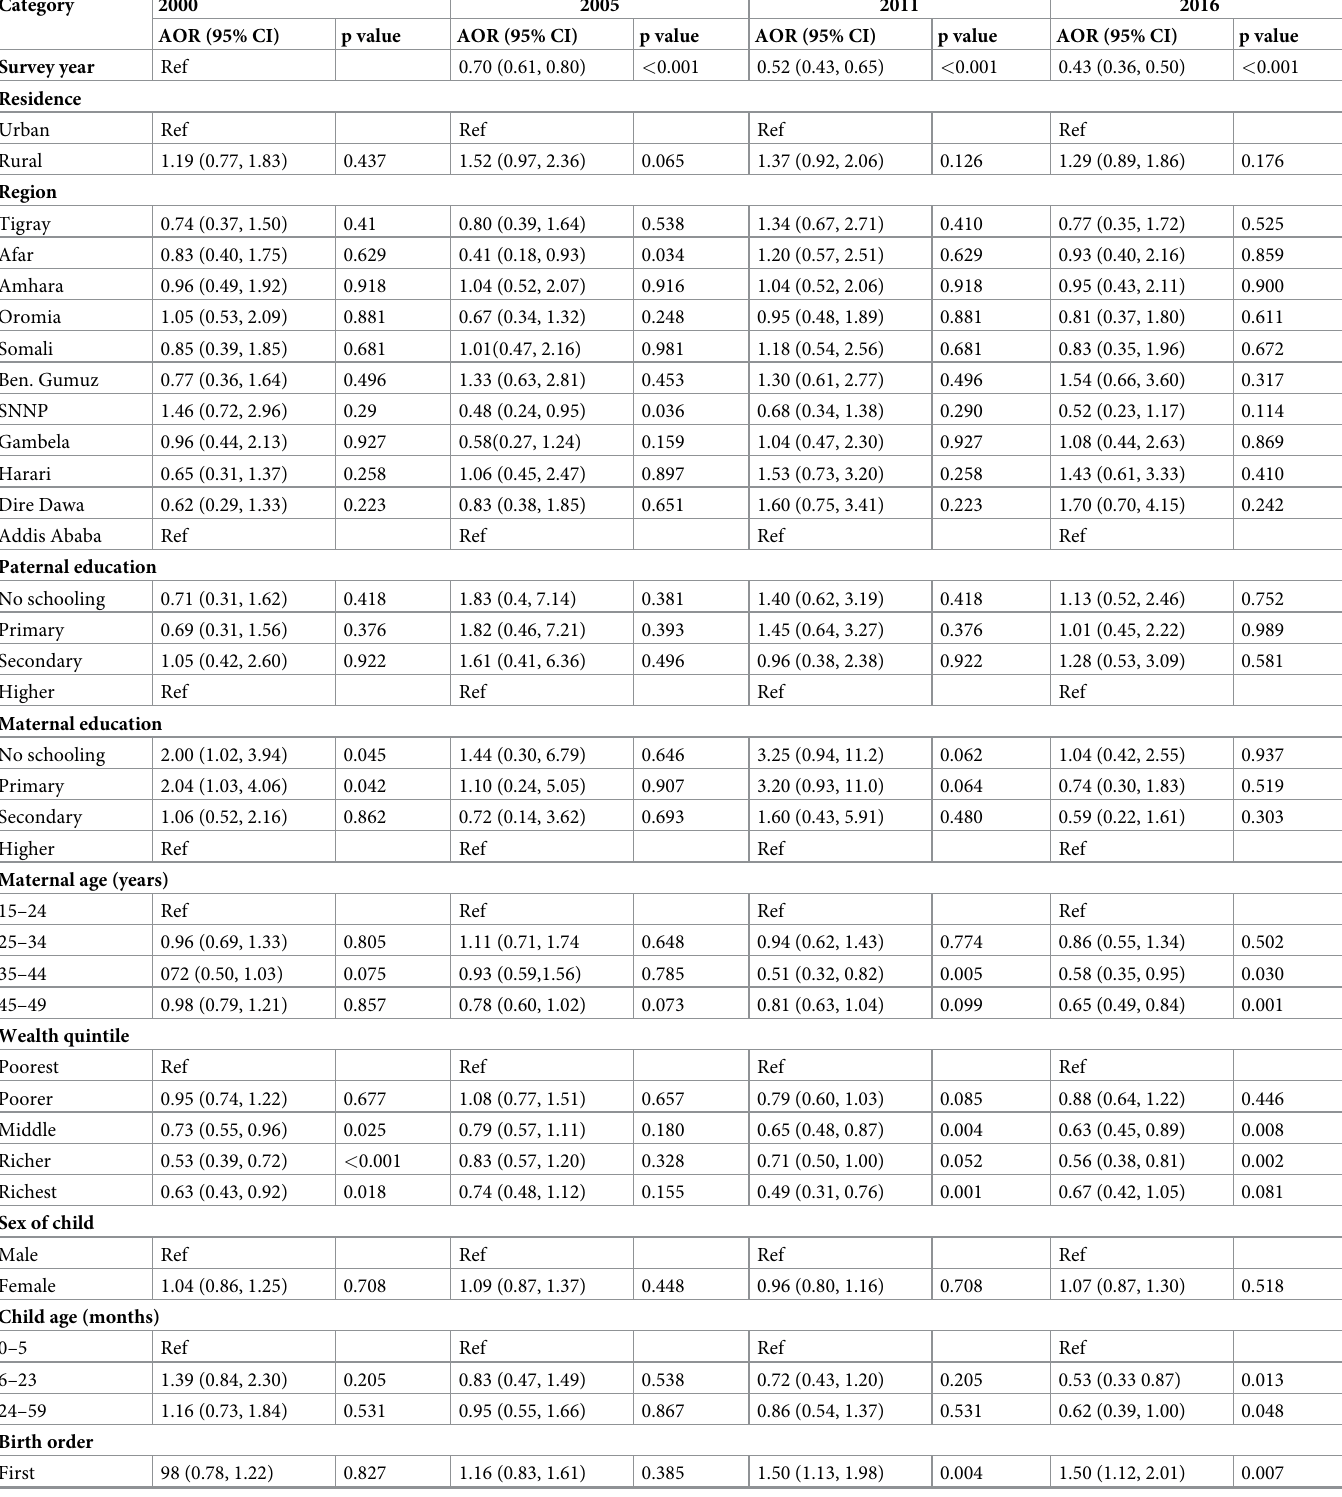
Table 3. Trends in adjusted odds ratios for children underweight, EDHS 2000 to 2016.